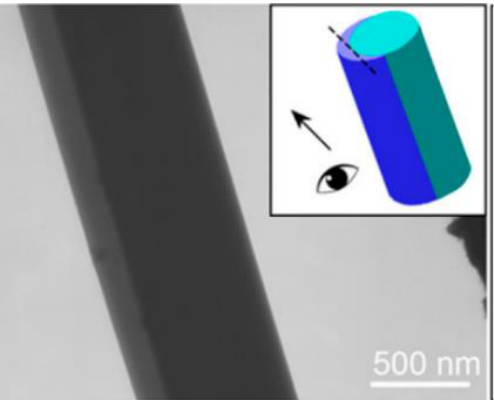
Figure 14. TEM image of the Janus nanofibre. Reproduced with permission from [131], copyright 2018 American Chemical Society.